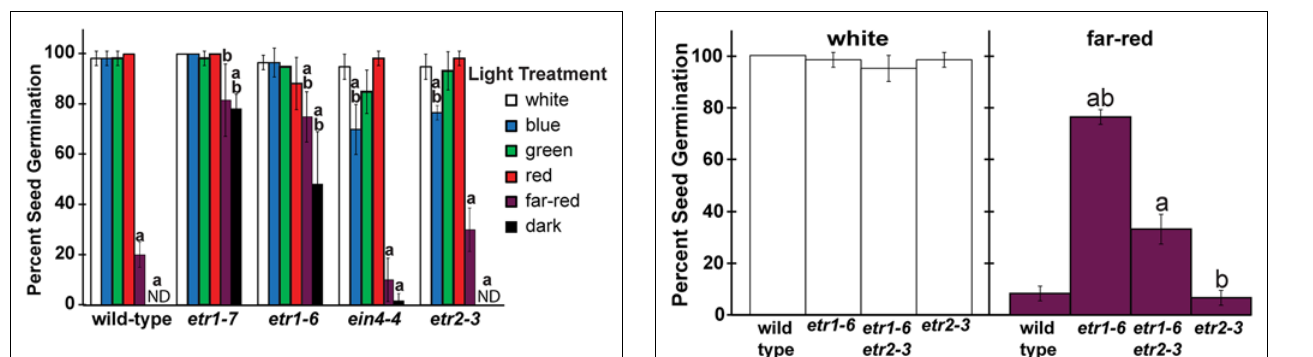
FIGURE 2 | ETR1 functions oppositely to ETR2 to control seed germination after treatment with far-red light. The percent of wild-type, etr1-6 , etr2-3 , and etr1-6;etr2-3 seed germination was determined 7 days after a far-red light treatment. For comparison, germination after a white light treatment is included. Plots show the average ± SD from at least three biological replicates. Data were analyzed by t -tests and differences considered statistically significant with P < 0.05. a Statistical difference from wild-type in that light condition; b Significant difference of the single mutant from the